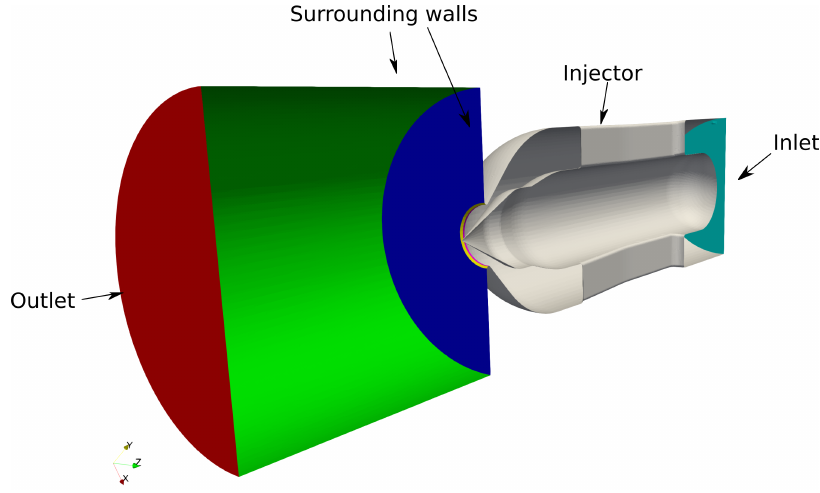
Figure 2. Half-view of the computational domain.